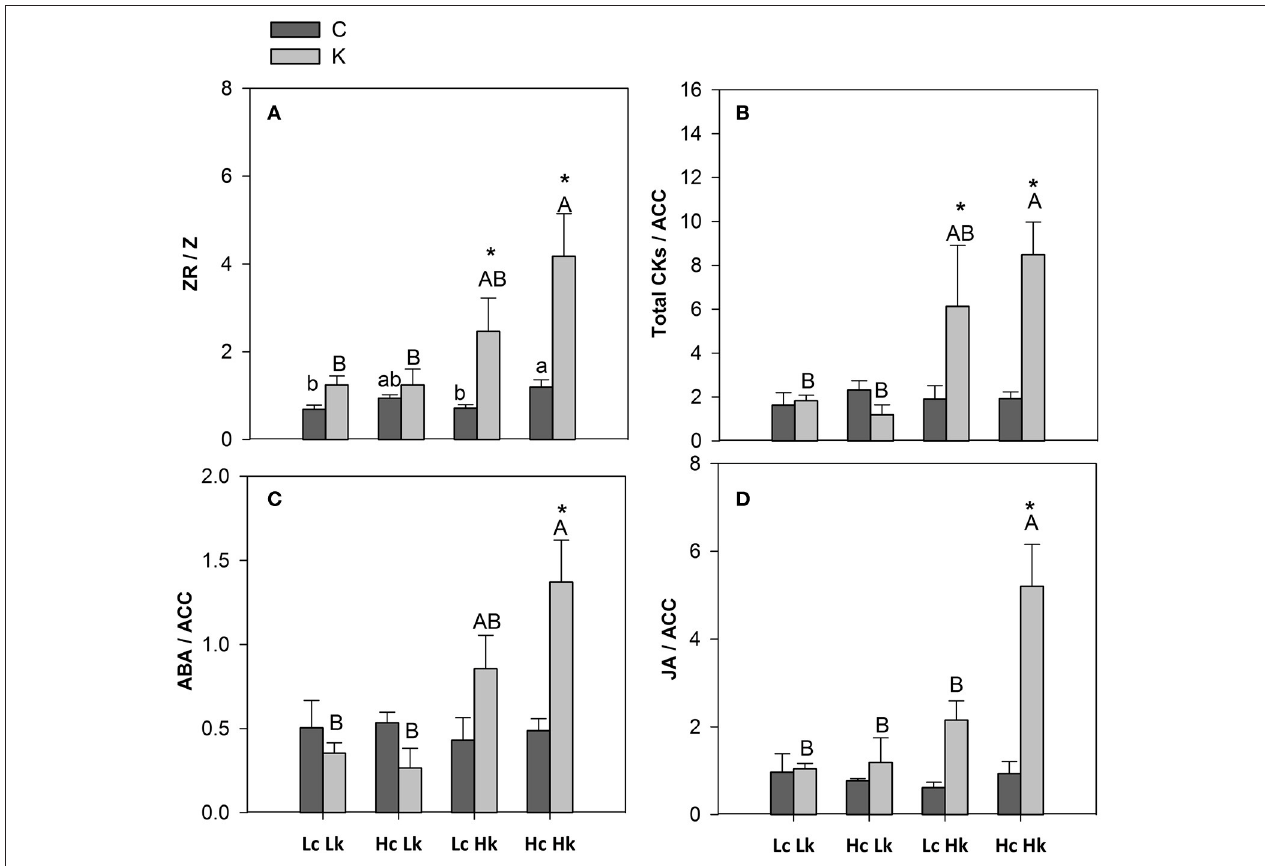
FIGURE 6 | Hormonal ZR/Z (A) , total CKs/ACC (B) , ABA/ACC and JA/ACC (D) ratios in the root xylem sap of the scion ( Solanum lycopersicum cv. Boludo F1) grafted onto a population of recombinant inbred lines (RILs) from a cross between Solanum lycopersicum × Solanum pimpinellifolium with high ( H ) or low ( L ) vigor growing under control ( c ) and low K ( k ) conditions during 48 days. Different letters indicate significant differences among graft combinations ( n = 12, P < 0.05) within each treatment. *indicate significant differences between control and low-K treated plants according to the Tuckey test ( P <